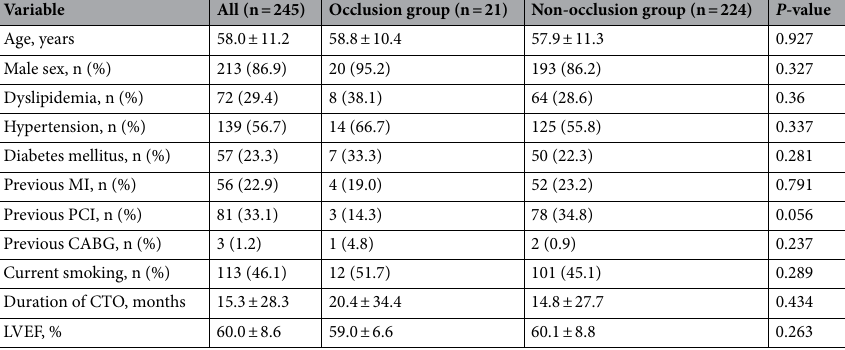
Table 1. Clinical characteristics. CABG coronary artery bypass grafting, CTO chronic total occlusion, LVEF left ventricular ejection fraction, MI myocardial infarction, PCI percutaneous coronary intervention.